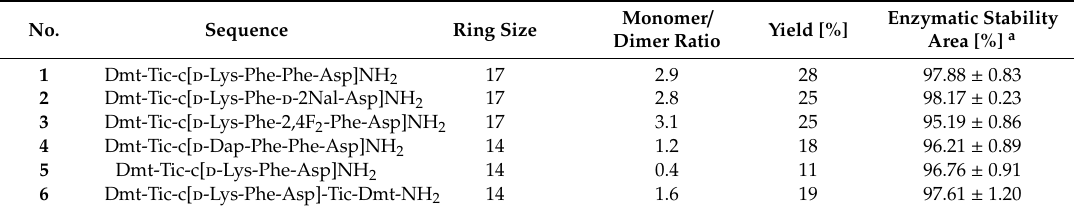
Table 1. Structure, monomer / dimer ratios, yield and enzymatic stability of analogs 1 – 6